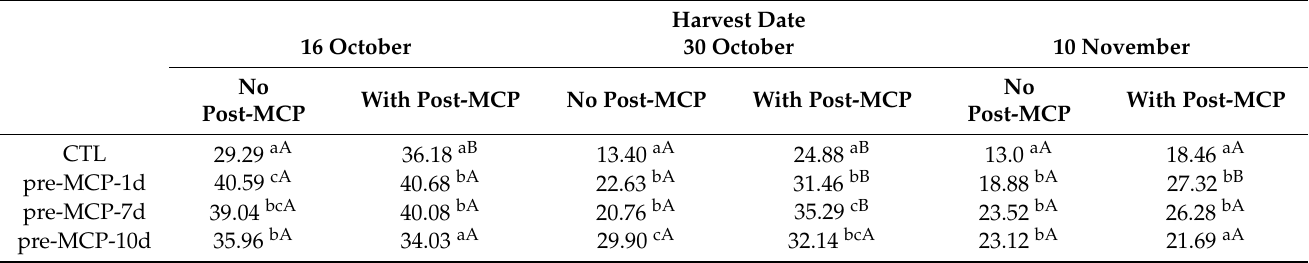
Table 1. Effect of preharvest 1-MCP applied on days 1 (pre-MCP-1d), 7 (pre-MCP-7d) or 10 (pre-MCP-10d) after ethephon treatment and postharvest 1-MCP (post-MCP) on ‘Rojo Brillante’ persimmon flesh firmness after the commercialization period (3d at 3 ◦ C plus 6 d at 20 ◦ C) on three harvest dates. CTL is the fruit not treated with pre-MCP.